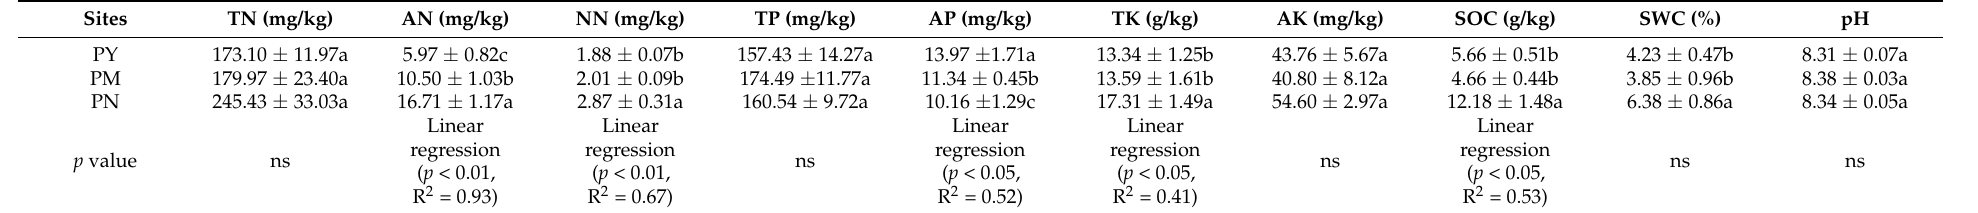
Table 1. The rhizosphere soil properties of P. tabuliformis at different stand